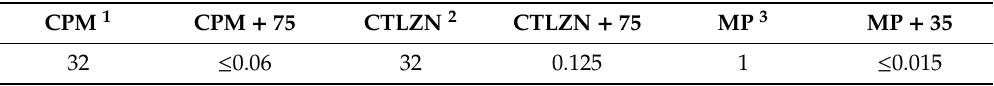
Table 5. Minimum inhibitory concentration (MIC, µ g / mL) of β -lactam antibiotics alone and when combined with compound 75 .